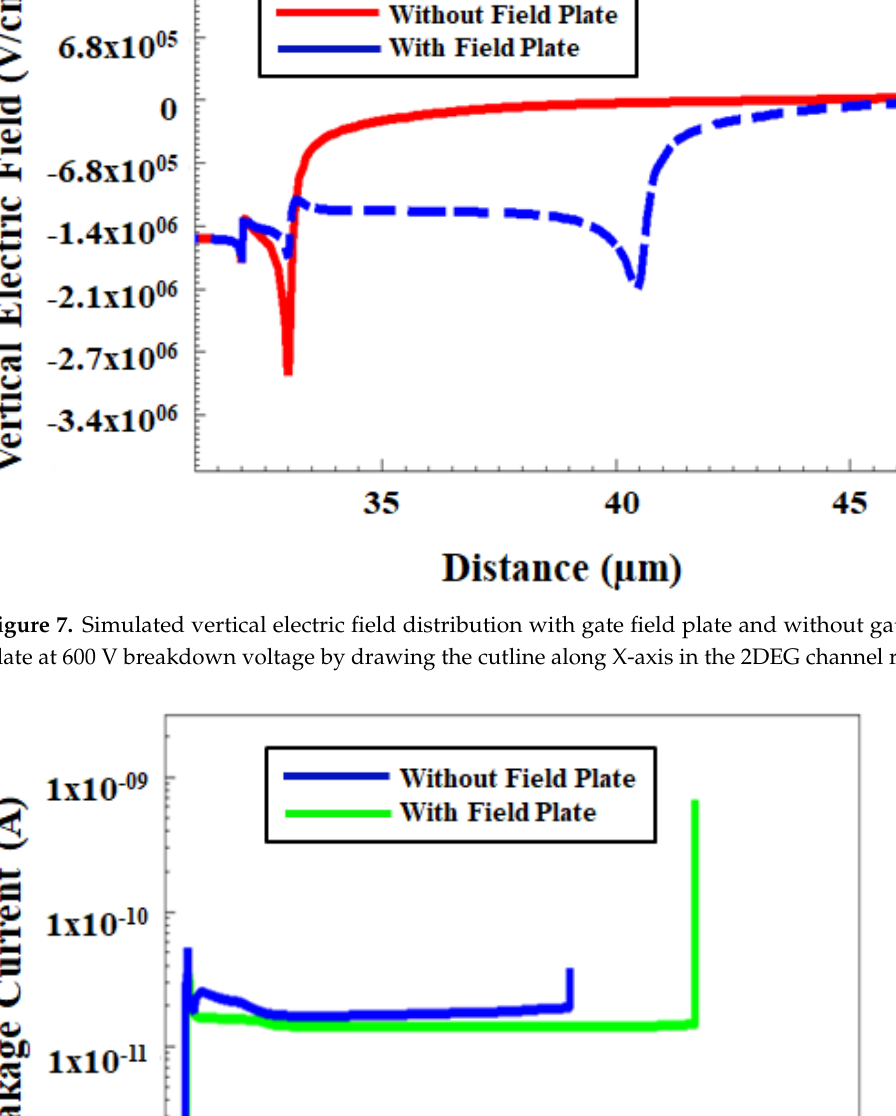
Figure 9. I d − V g characteristics comparison of simulated data and GaN wafer experimental data. The drain current stays comparatively saturated with an additional negative sweep of the gate electrode (the drain leakage current is measured in OFF state condition). As